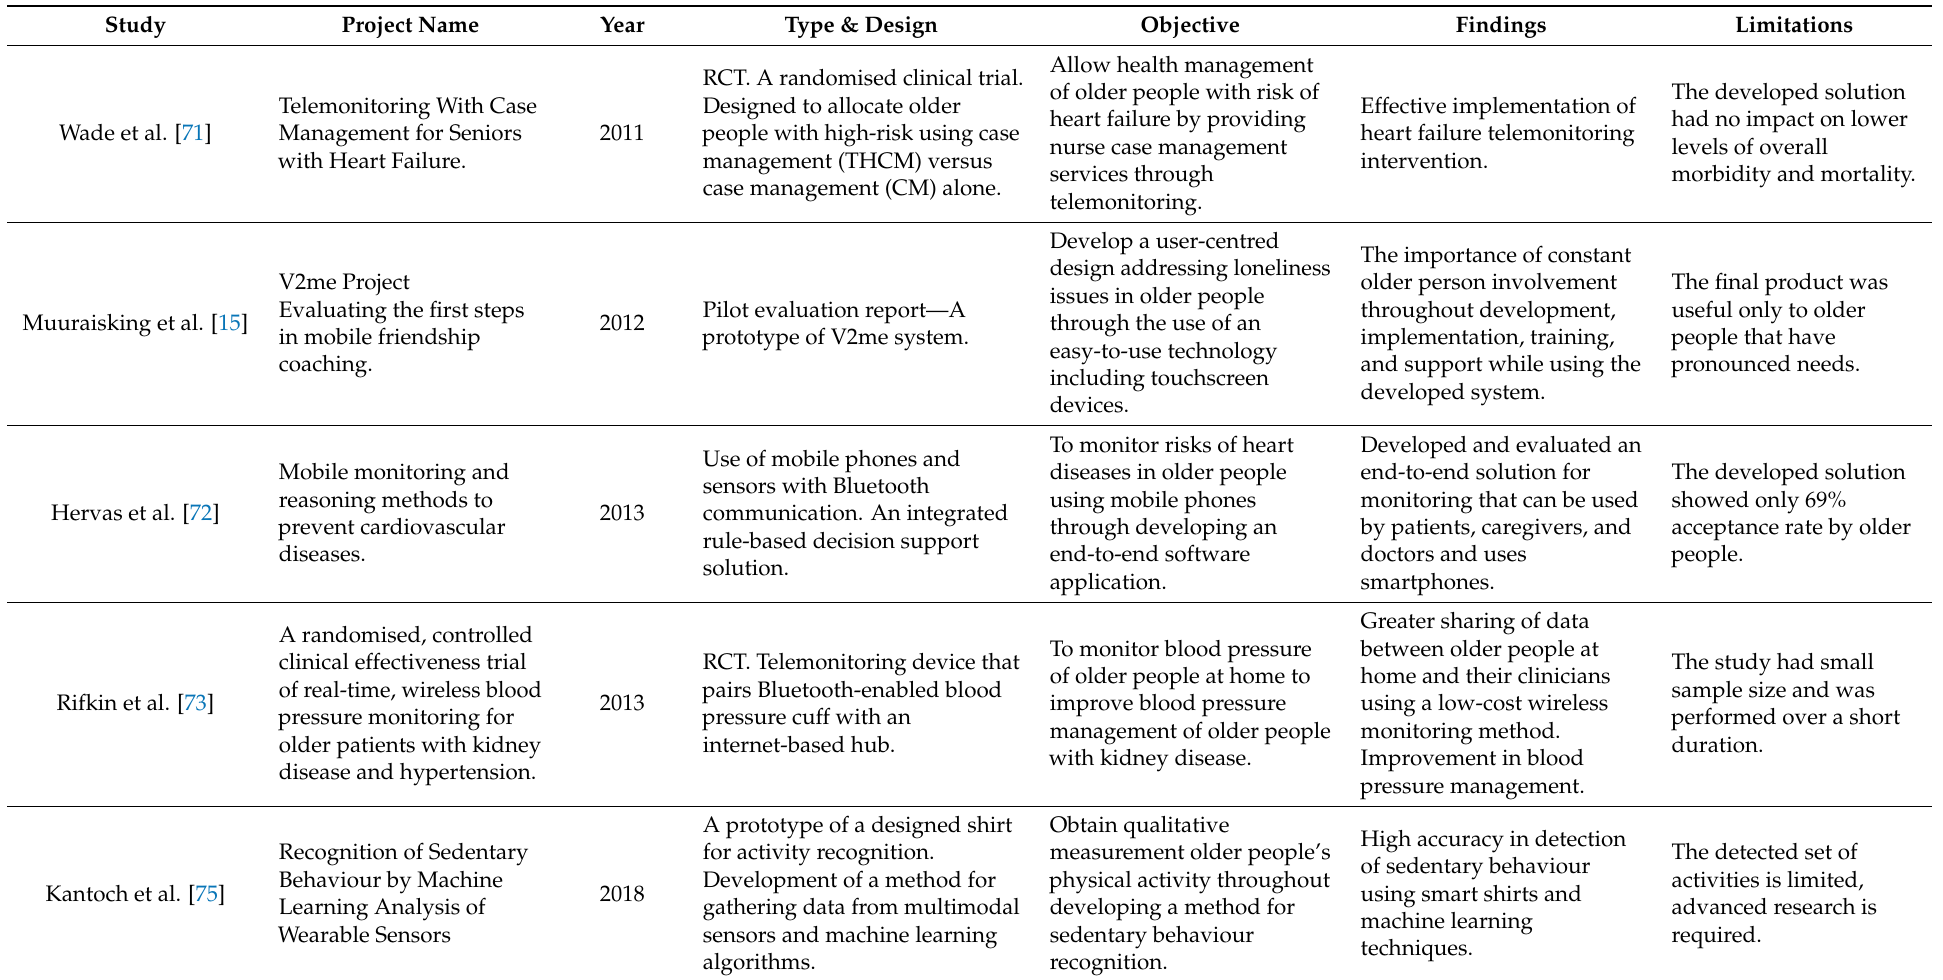
Table 3. ICT solutions for assistive living of older people with heart